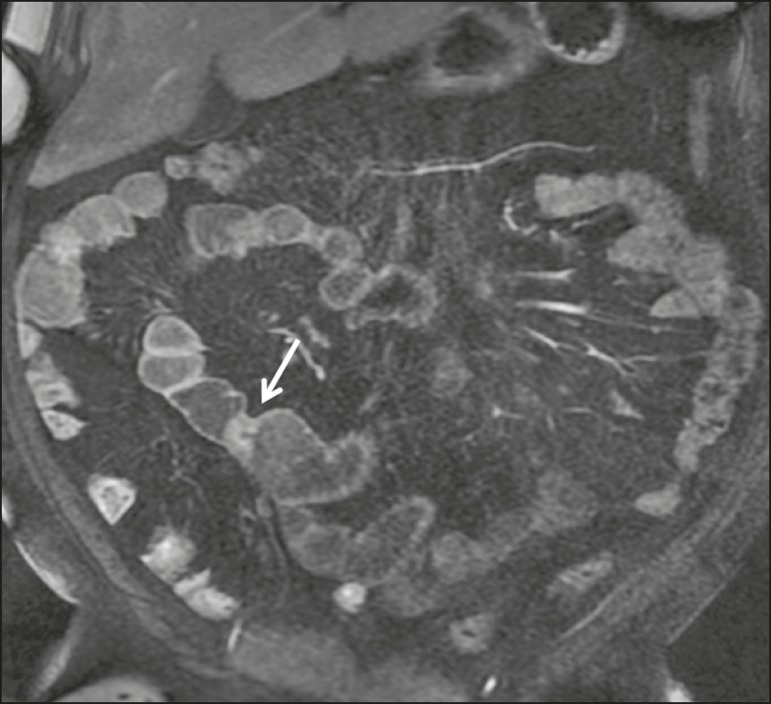
Coronal, paramagnetic contrast-enhanced (gadolinium), fat saturated T1-weighted MRE sequence showing wall thickening with focal stenosis (arrow) and dilatation of the prestenotic segment.